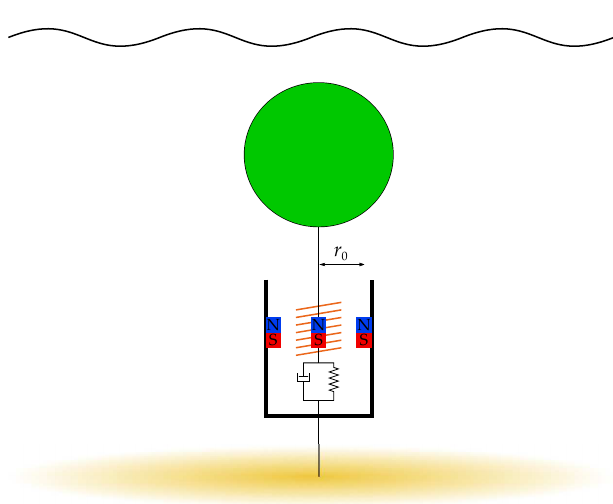
Fig. 3. An example WEC with a magnetic bistable mechanism within the